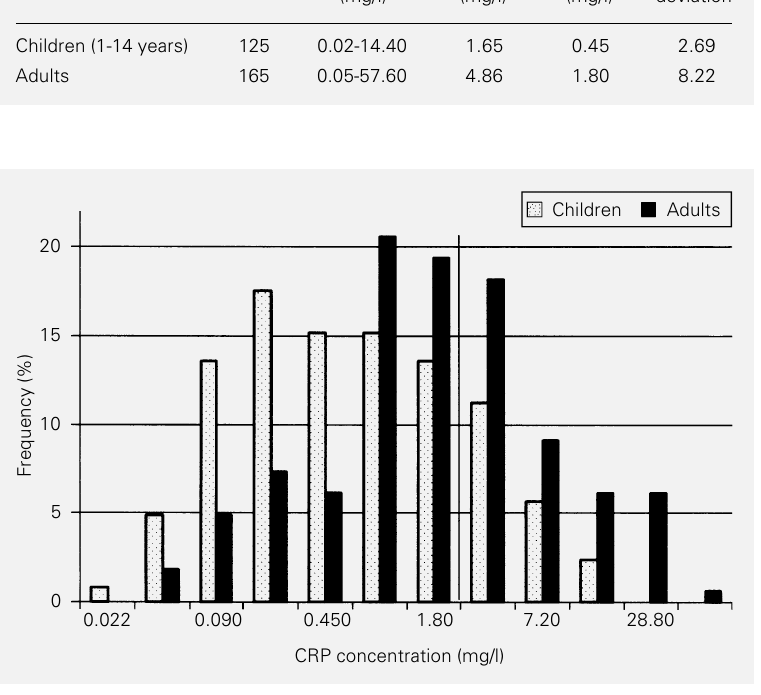
Figure 1 - Distribution of CRP levels in the sera of 125 normal children, aged 1 to 14 years, and 165 healthy blood donors determined by ELISA. Most of these sera (80.8% of children and 60% of adults) had CRP concentrations below the detection limit of the radial immun- odiffusion assay (2 mg/l), indicated by the vertical